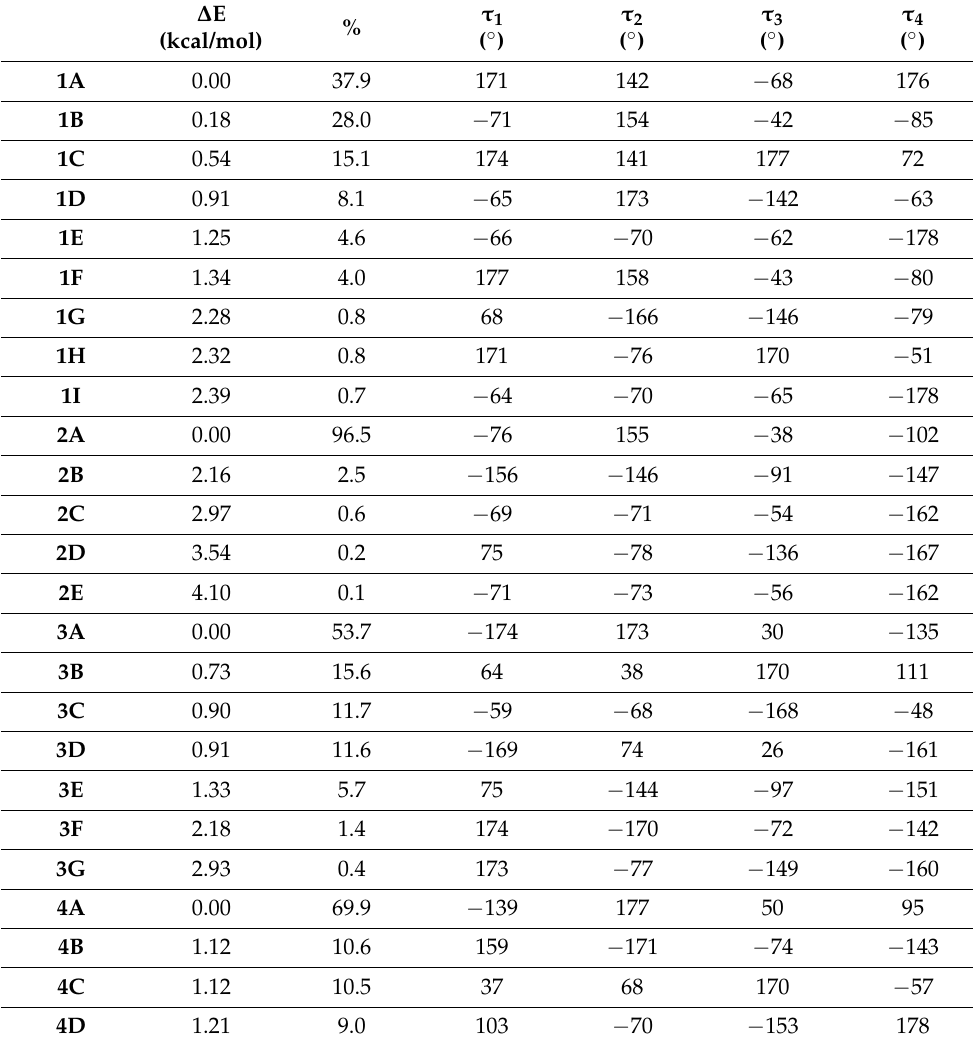
Table 4. Geometrical features, relative energies, and equilibrium percentages in water of the located conformations of compounds 1 – 4